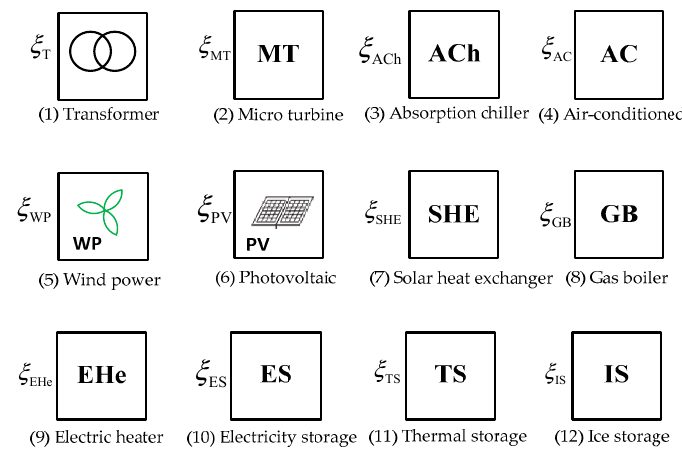
Figure 5. Available energy converter and storage elements for the desired hub.